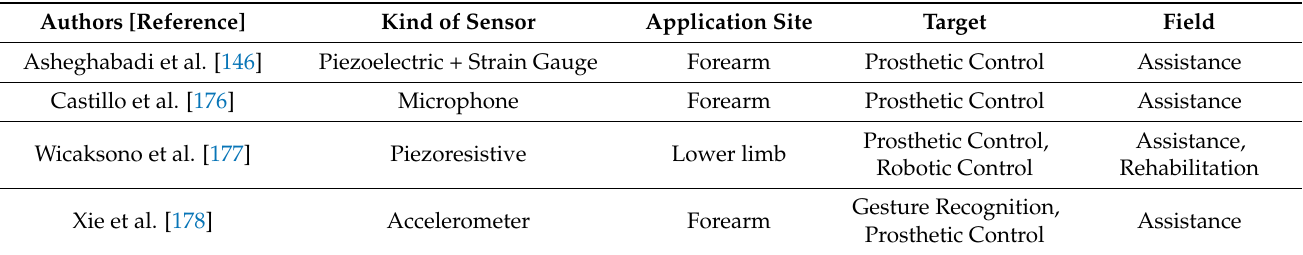
Table 8. Muscle vibrations-based HMIs.